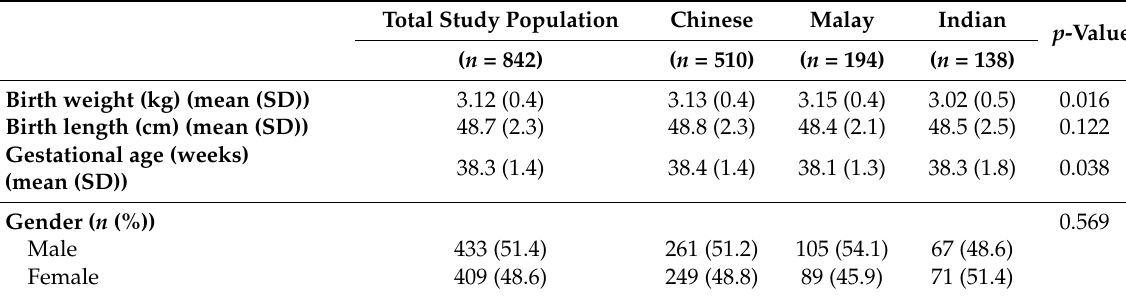
Table 1b. Profile of the infants in the